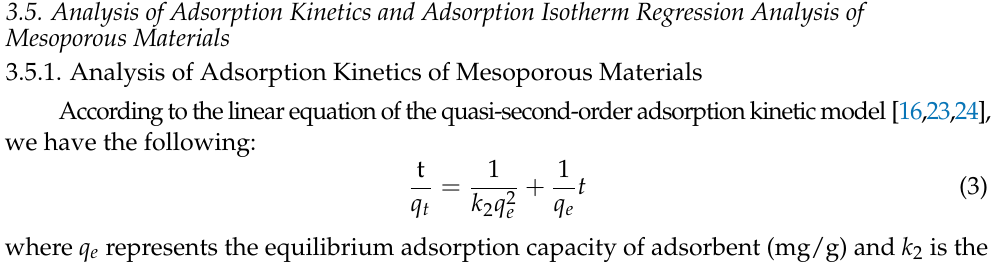
Table 4. Adsorption kinetic data of crystal violet on MCM-41. t